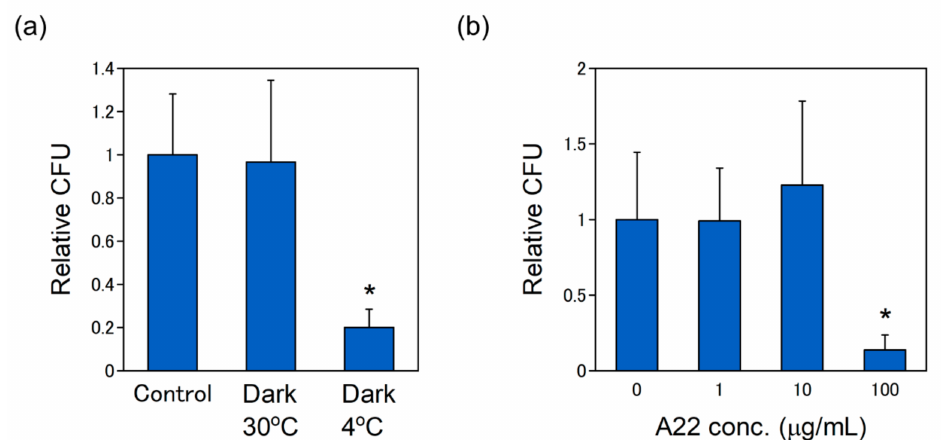
Figure 5. The pDNA delivery e ffi ciency under various conditions. ( a ) E ff ect of growth light and temperature conditions on the transformation e ffi ciency. The pDNA delivery was conducted at 30 ◦ C or 4 ◦ C under far-red illumination or in the dark. The data were normalized by the ‘control’ condition (far-red light at 30 ◦ C). Asterisk shows the significant di ff erence compared to the control ( p < 0.01). ( b ) E ff ect of A22 on the delivery e ffi ciency. The pDNA delivery was carried out in the presence of 0, 1, 10 and 100 µ g / mL of A22. The concentration of dTat-Sar-EED5 was fixed to 100 µ M. The data were normalized by ‘0 µ g / mL A22 (cid:48) . Data are the mean ± SD of four cell cultures. Asterisk shows the significant di ff erence compared to the control (without A22) ( p < 0.01). Statistically significant di ff erences between samples were determined by the Student t -test.